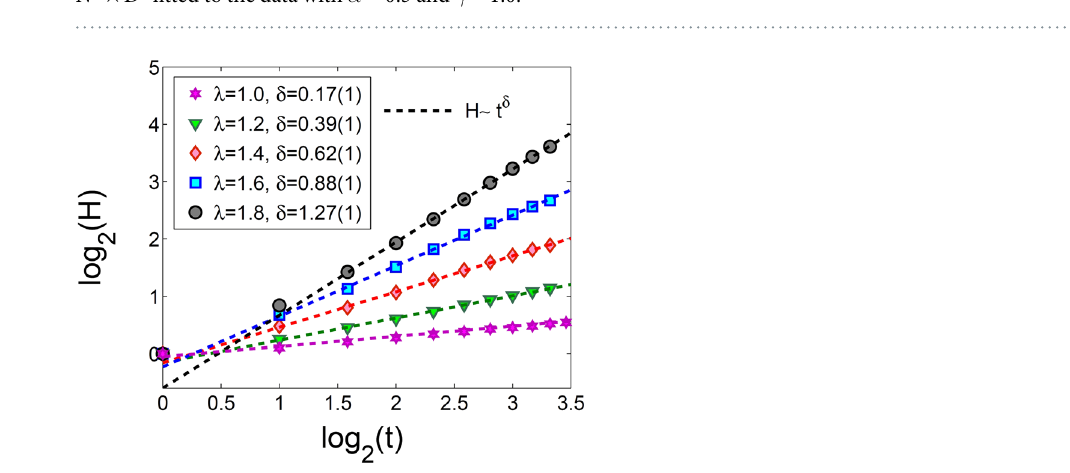
Figure 8. Plots of E ( S | D ) versus D for systems with λ = 1.2 and different values of N . Dashed lines are plots of N α × D γ fitted to the data with α = 0.5 and γ = 1.0.